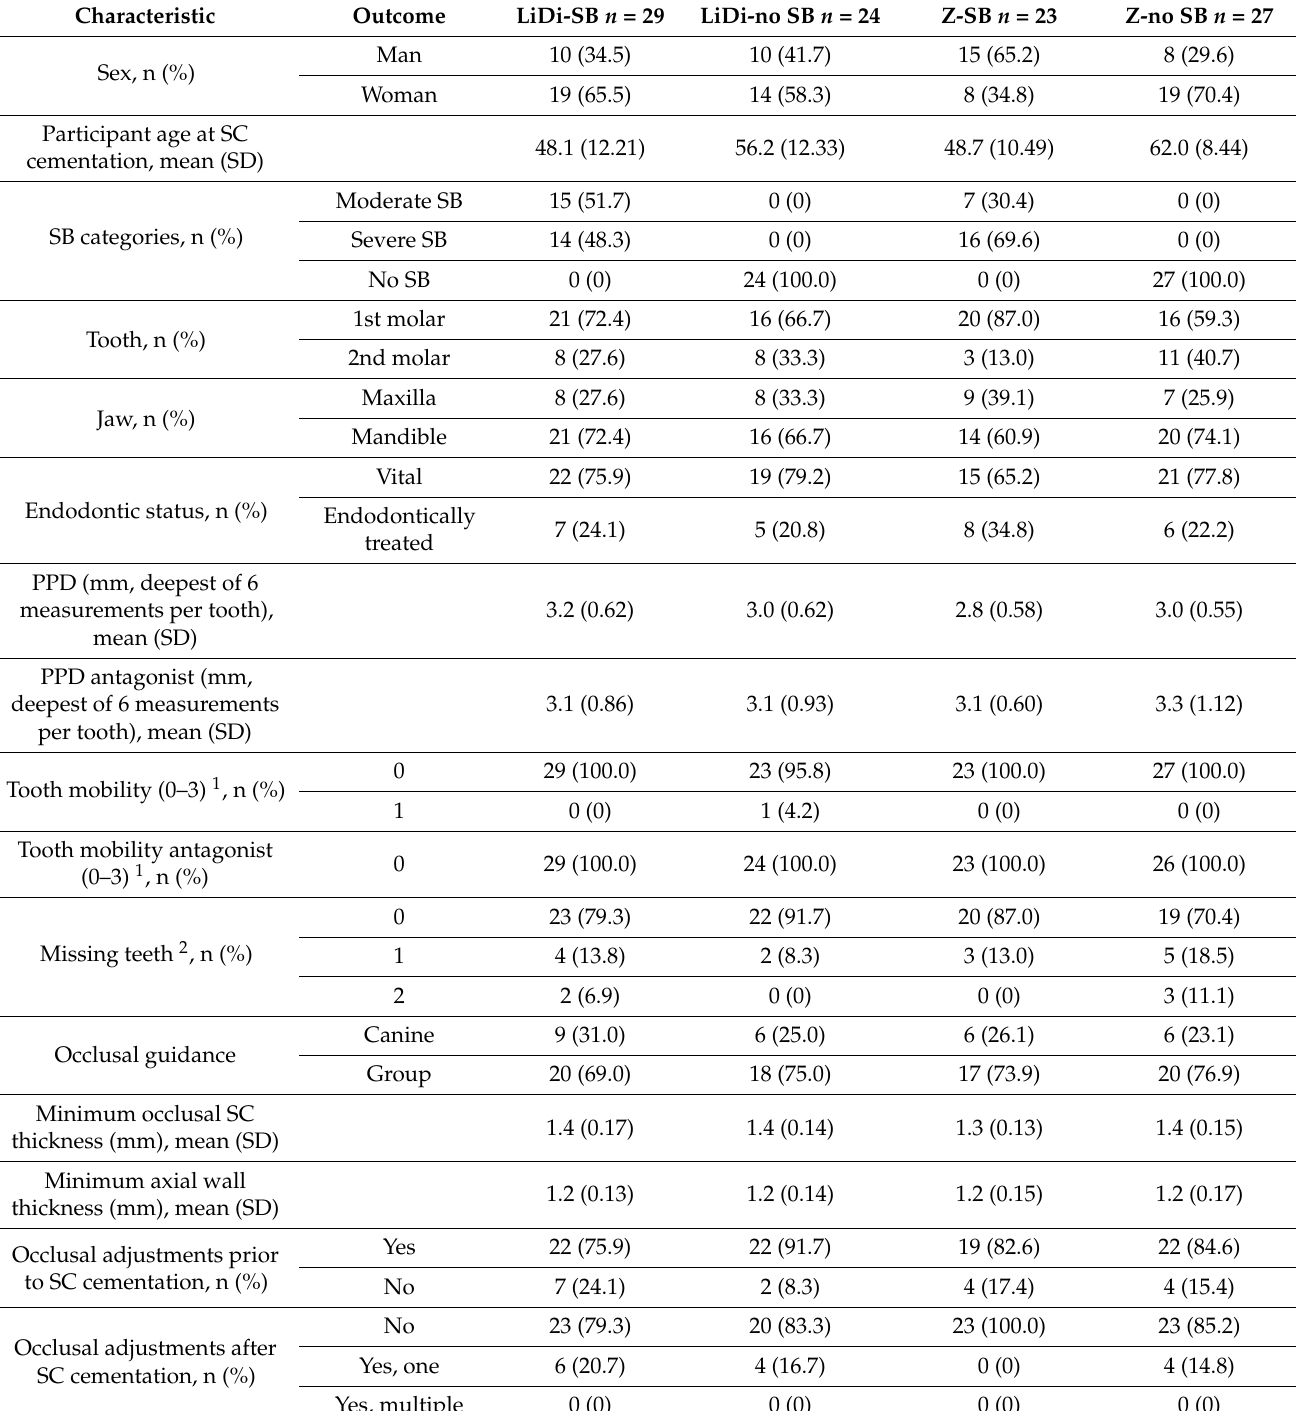
Table 1. Participant and restoration characteristics in study groups. LiDi: lithium disilicate, Z: zirconia, SC: single crown, SD: standard deviation, SB: sleep bruxism, PPD: probing pocket